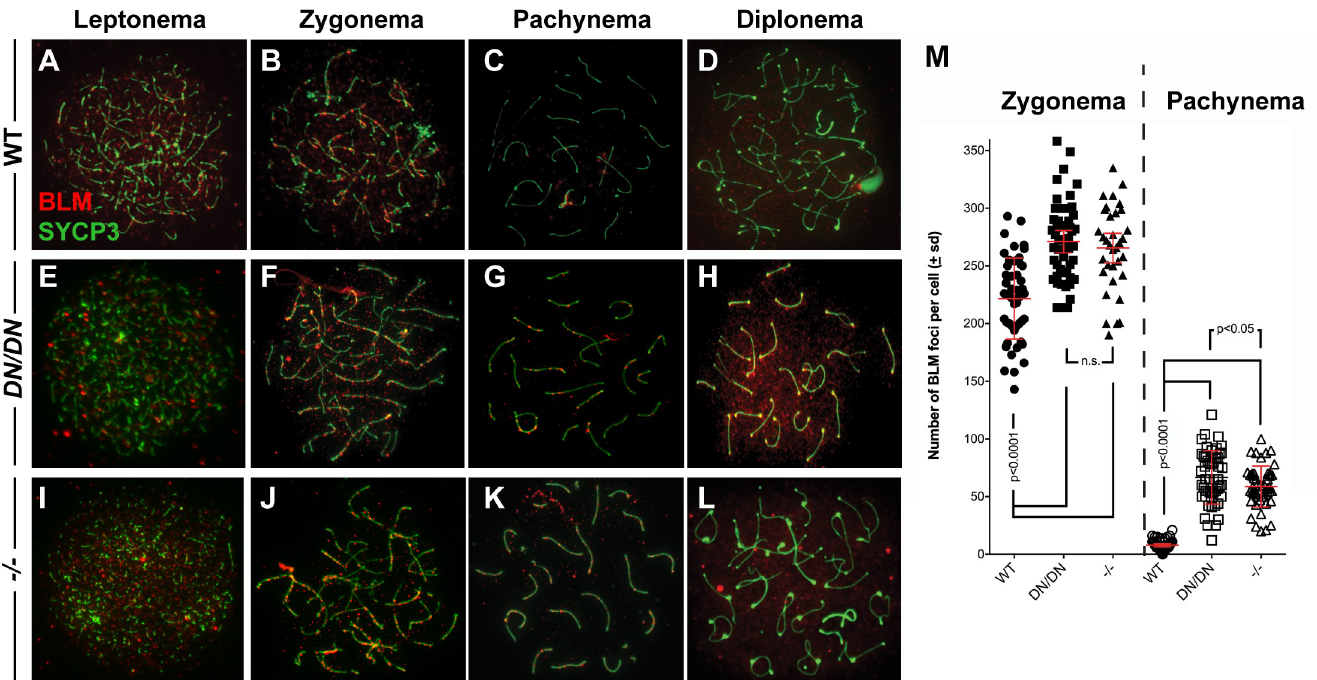
Fig 3. Mlh3 DN/DN spermatocytes show a persistence of BLM in pachynema. Meiotic spreads chromosomes from (A-D) WT, (E-H) Mlh3 DN/DN , and (I-L) Mlh3 -/- males showing the localization of BLM (red) on synaptonemal complex protein SYCP3 (green) throughout the progression of prophase I. (B, F, J, M) In zygonema, Mlh3 DN/DN and Mlh3 -/- cells show significantly more BLM foci localized to the chromosome cores than WT (WT mean ± s.d. = 221.6 ± 35.1 foci, Mlh3 DN/DN mean ± s. d. = 271.1 ± 34.2 foci, Mlh3 -/- mean ± s.d. = 265.5 ± 36.6 foci; p values indicated on graph, by unpaired t-test with Welch’s correction, and using Bonferroni’s adjustment for multiple comparison). (C, D, K, M) In pachynema, BLM is no longer present on the chromosome cores of WT cells whereas Mlh3 DN/DN and Mlh3 -/- cells show hyper-accumulation of BLM on the autosomes and the sex body (WT mean ± s.d. = 7.8 ± 4.7 foci, Mlh3 DN/DN mean ± s.d. = 66.7 ± 23.2 foci, Mlh3 -/- mean ± s.d. = 58.7 ± 17.8 foci; p values indicated on graph, by unpaired t-test with Welch’s correction, and using Bonferroni’s adjustment for multiple comparison), which persists into diplonema. At zygonema, the frequency of BLM foci in Mlh3 DN/DN and Mlh3 -/- cells is not statistically different, whereas by pachynema, the number of BLM foci remains significantly elevated in Mlh3 DN/DN spermatocytes, relative to that observed in Mlh3 -/- cells (p < 0.05, unpaired t-test). By diplonema, clear and quantifiable foci are no longer observed in spermatocytes from mice of all genotypes. However, the background staining intensity for these images is observed at standardize exposure settings for image acquisition, so the background staining is comparable between genotypes. For all chromosome imaging and foci counts, at least 3 mice of each genotype were observed for each staining